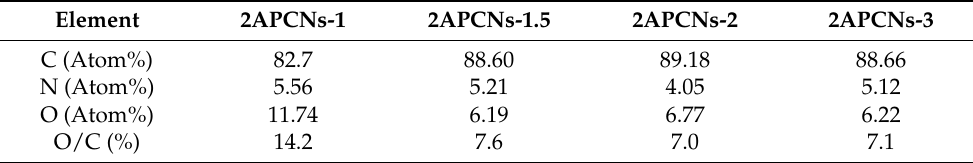
Table 1. Elemental analysis of 2APCNs products with different activation holding